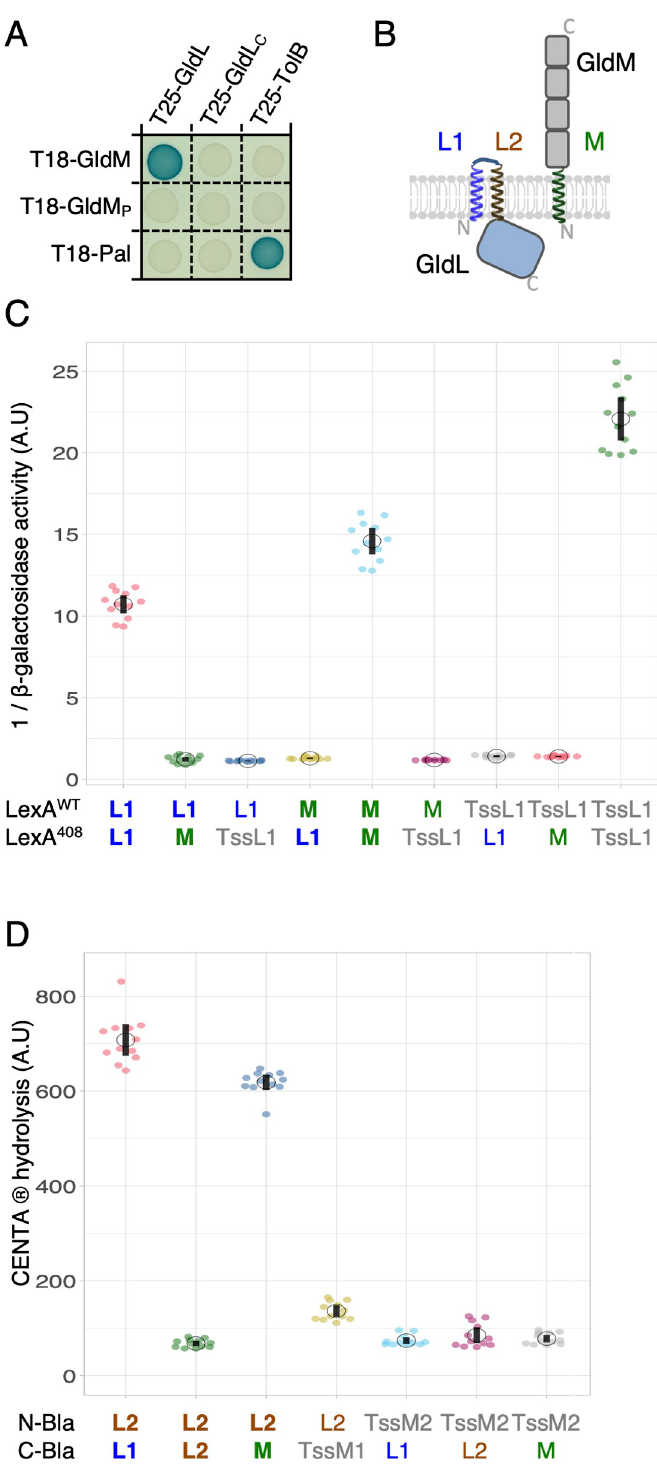
Fig 2. Interactions between GldL and GldM TMHs. (A) Bacterial 2-hybrid assay. GldL–GldM interaction is dependent on their TMHs. BTH101 cells producing the indicated proteins (GldL and GldM) or domains (GldL C , cytoplasmic domain of GldL, amino acid 59 to 189; GldM P , periplasmic domain of GldM, amino acid 36 to 513) fused to the T18 and T25 domain of the Bordetella adenylate cyclase were spotted on X-Gal-IPTG reporter LB agar plates. The blue color of the colony reports interaction between the 2 partners. Controls include T18 and T25 fusions to TolB